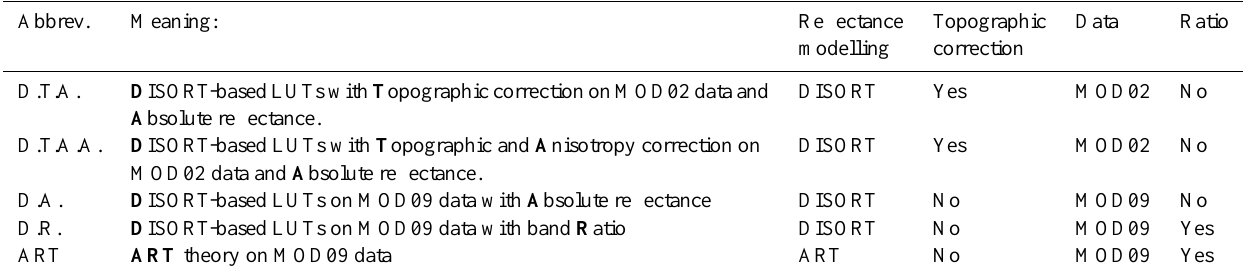
Table 4. Nomenclature of the retrieval methods.